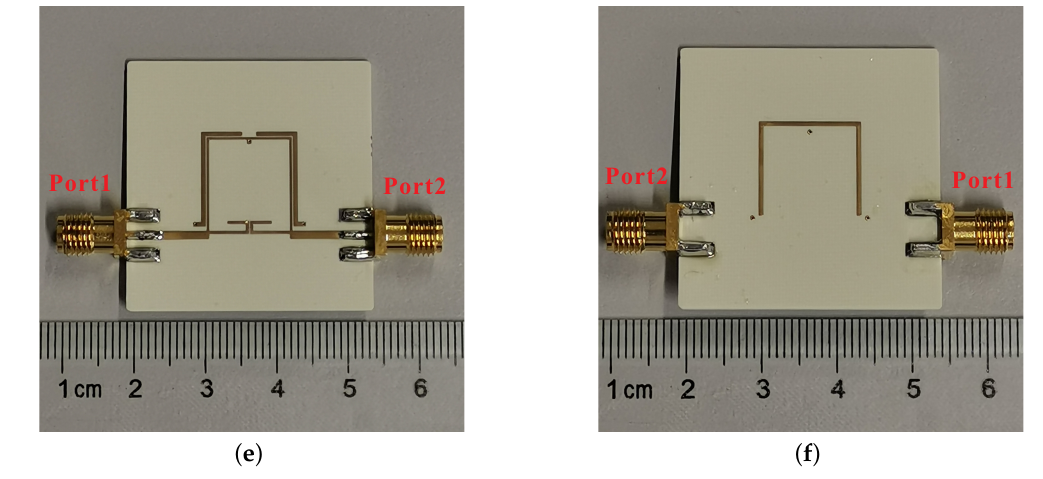
Figure 1. Configuration of the proposed bandpass filter (BPF) ( a ) Top layer. ( b ) Middle layer. ( c ) Bottom layer. ( d ) 3D view. ( e ) Front view of the proposed BPF. ( f ) Bottom view of the proposed